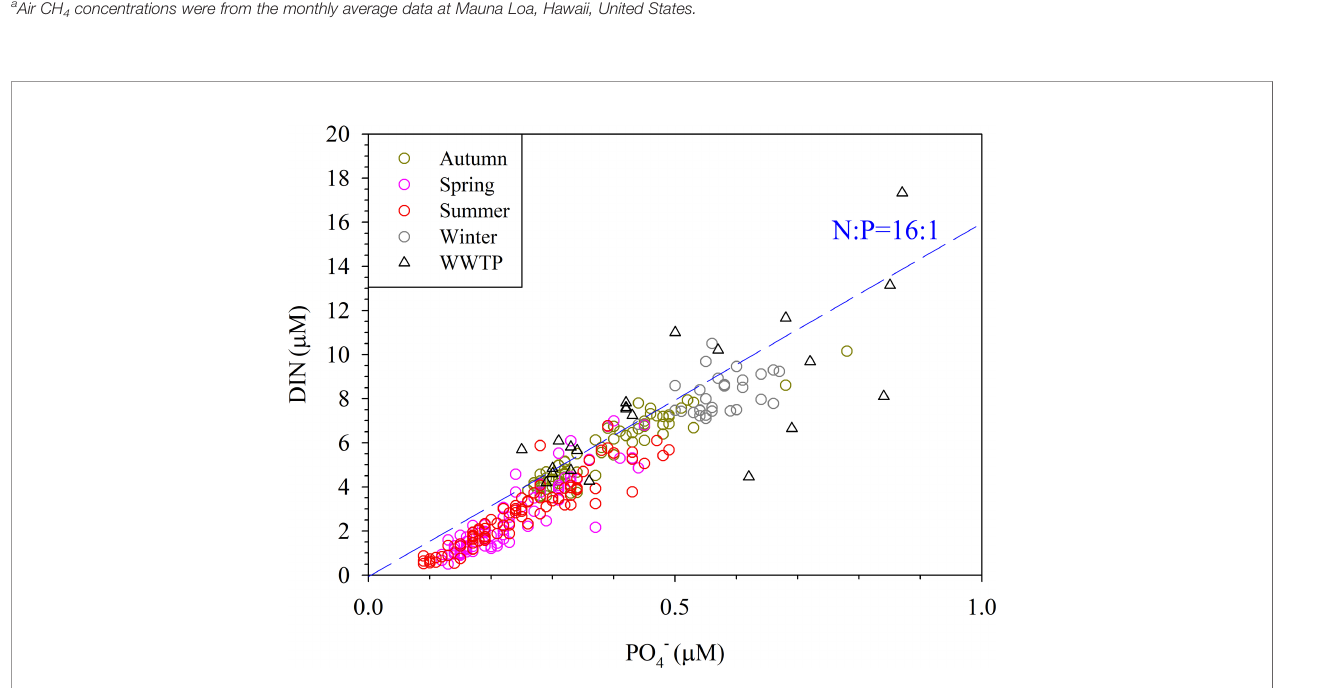
FIGURE 3 | The DIN concentration ( m M) versus PO 4 concentration ( m M), obtained at 66 stations during four cruises from November 2019 to January 2021. D presents the data in fl uenced by ocean outfall pipe of wastewater treatment plant.